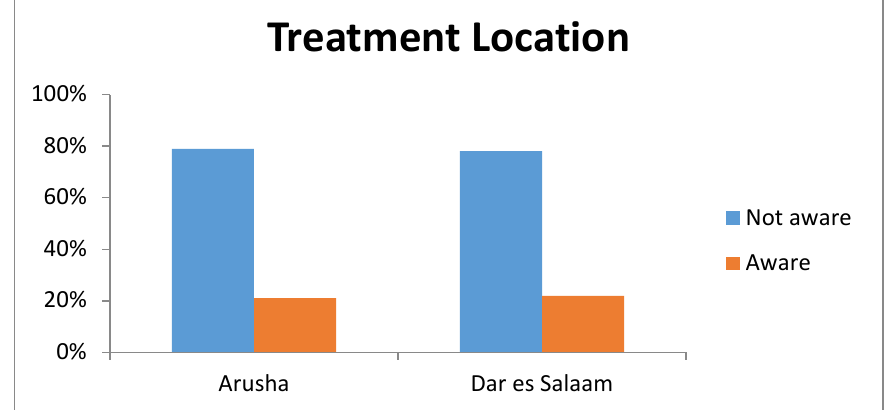
Figure 2. Awareness on treatment location in Dar es Salaam and